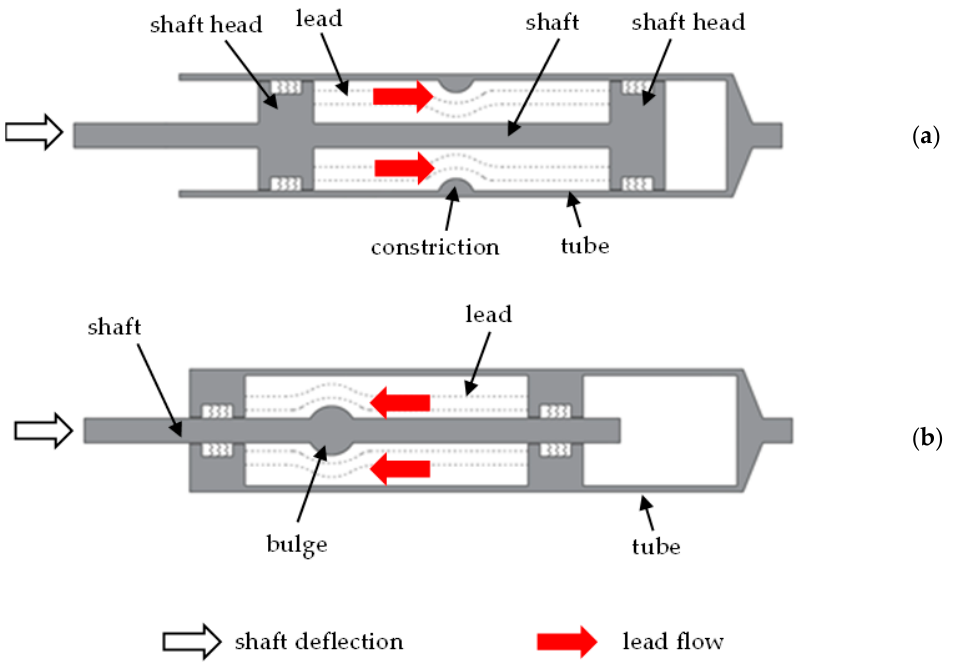
Figure 1. Longitudinal section of lead extrusion dampers: constricted tube type ( a ); bulged shaft type ( b ). Adapted from [24].